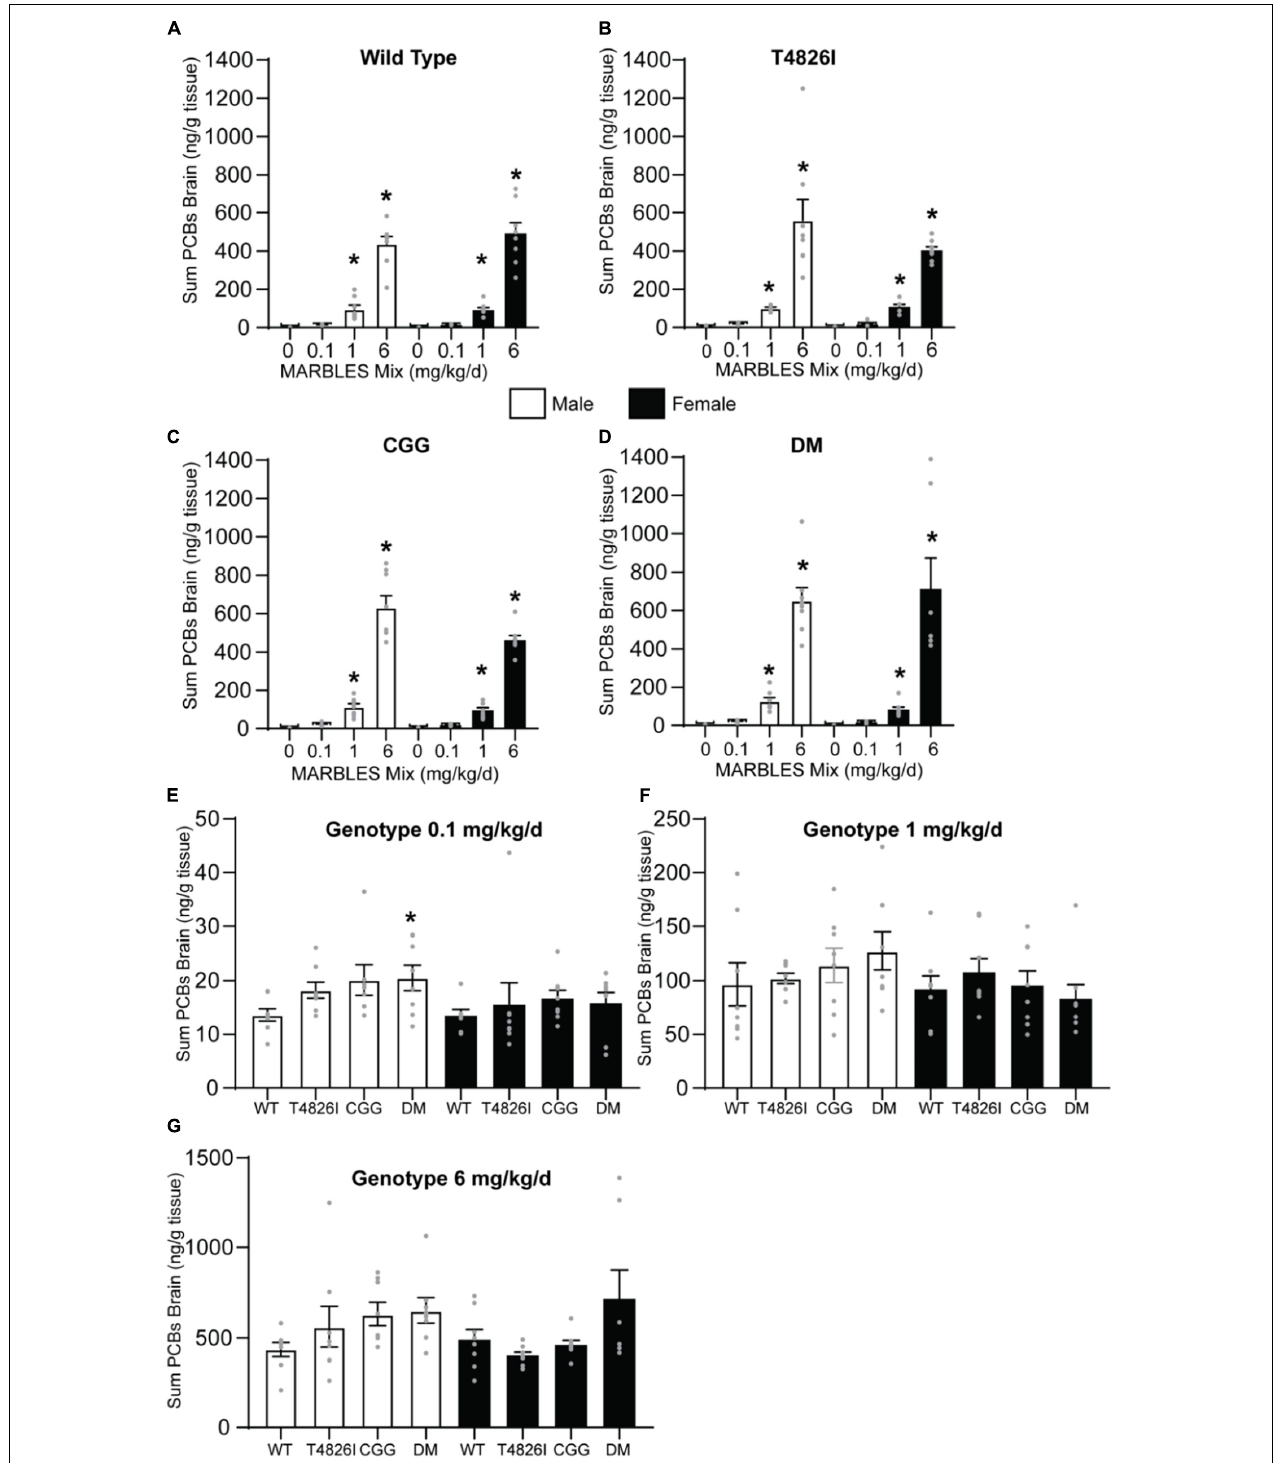
FIGURE 8 | PCB brain burden increased in a dose-dependent manner independent of genotype. (A–D) The sum PCB levels in brain tissue of (A) WT, (B) T4826I, (C) CGG, or (D) DM mice developmentally exposed to varying doses of the MARBLES PCB mix in the maternal diet. (E) The sum PCB levels in the brain tissue of each genotype at the 0.1, (E) 1, (F), or 6 (G) mg/kg/d exposure group. Data presented as mean ± SEM ( n = 7–9). The sum of PCBs that were above 70% detection frequency in the 1 and 6 mg/kg/d groups were used and include PCB 28, 52, 101, 118, 138, 153, and 180. ∗ Indicates significant difference from sex-matched vehicle control at ∗ p < 0.05 as determined using a one-way ANOVA or Kruskal Wallis test with post hoc Holm-Sidak’s multiple comparisons test or Dunn’s test, respectively. Detailed information on individual PCB congener content can be found in Excel spreadsheets in Supplementary Data Sheet 2 .